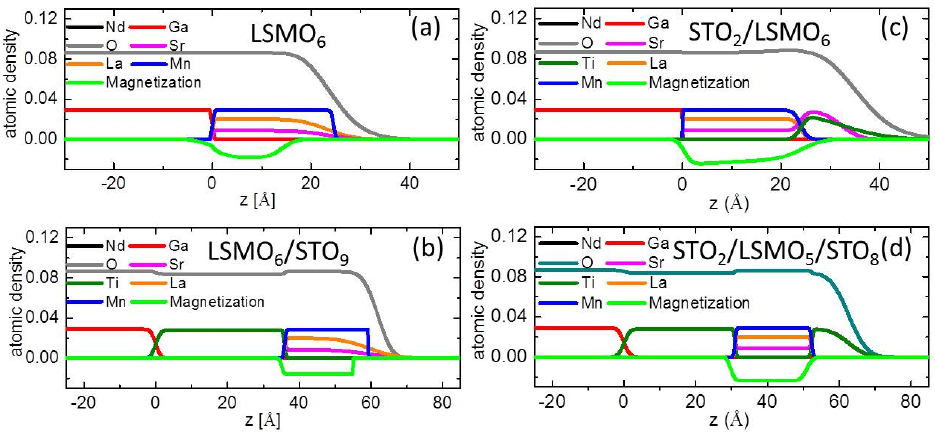
Figure 6. Stoichiometry and magnetic profiles for different LSMO films with/without STO buffer/capping layers. The depth profiles of the Ga, Ti, Mn, Nd, La, Sr, O atomic concentration, and Mn magnetization were measured at 20 K. Reproduced with permission from Liao et al. [40]. Copyright 2017 John Wiley and